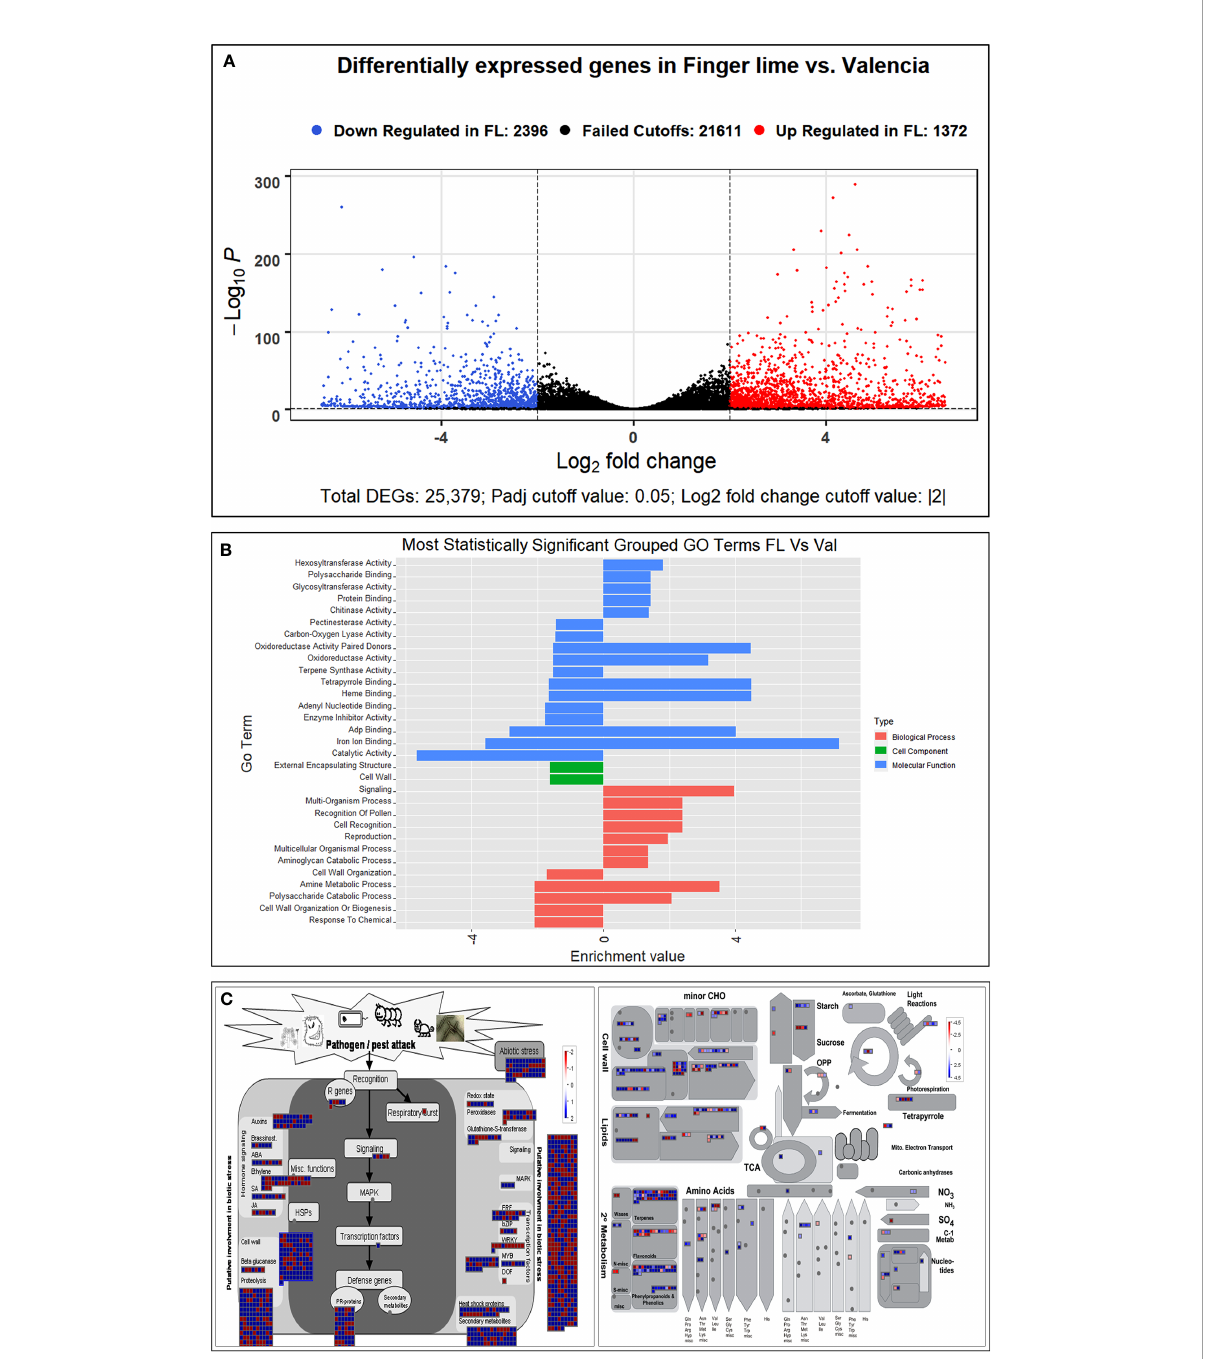
FIGURE 2 (A) Volcano plot of the upregulated and downregulated DEGs. Genes with an adjusted p value of less than 0.05 found with DESeq were assigned as differentially expressed. (B) Graphical view of the most statistically signi fi cant upregulated and downregulated enriched GO terms in Finger line trees as compared to ‘ Valencia ’ trees. Statistically signi fi cant DEGs were analyzed using AgriGO v2 and REVIGO. (C) Differentially expressed genes as identi fi ed following MAPMAN analysis. Regulation of stress-related gene pathways by Ca Las infection in the infected Finger Lime (Left). Overview of the differentially expressed genes related to the metabolic pathways in Finger lime and ‘ Valencia ’ sweet orange (Right). Genes that were signi fi cantly upregulated following Ca Las infection are displayed in blue, and downregulated genes are displayed in